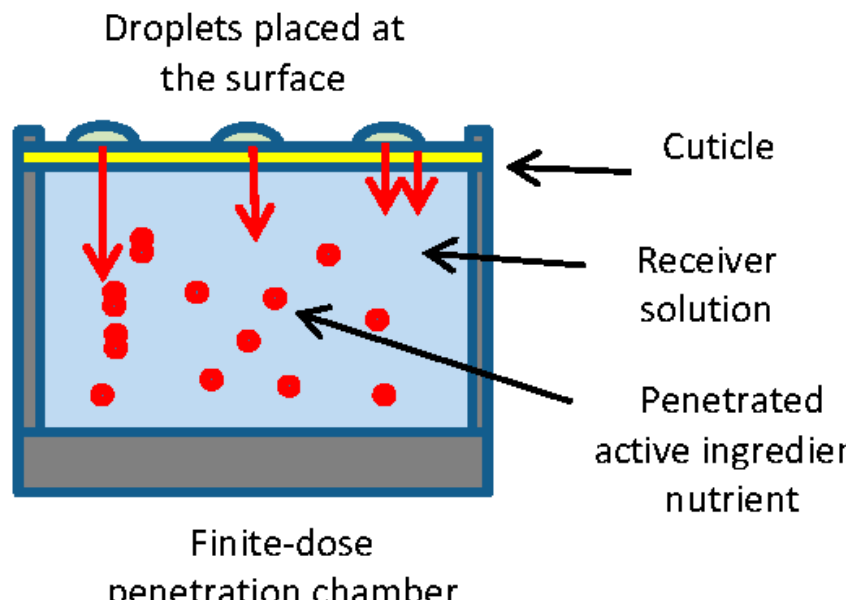
Figure 1. Schematic representative of the penetration chamber. The stainless steel box is filled with deionized water as receiver solution which is in close contact to the mounted cuticular member (CM). The active ingredient (a.i.) of applied droplets penetrates through the CM [17].